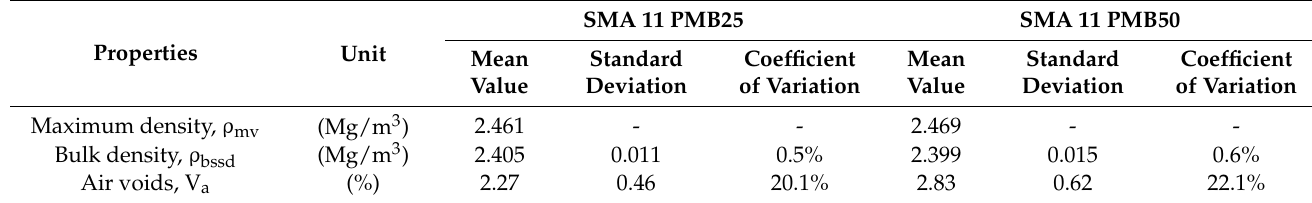
Table 5. Volumetric characteristics of the studied asphalt